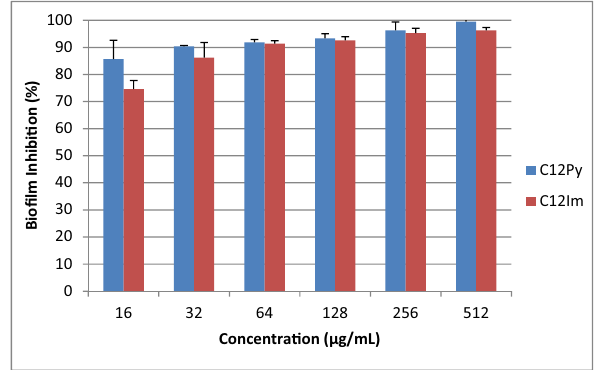
Figure 5: Inhibitory activity of C12 NPs at di ff erent concentrations against the bio fi lm formation of Escherichia coli in 48 h.